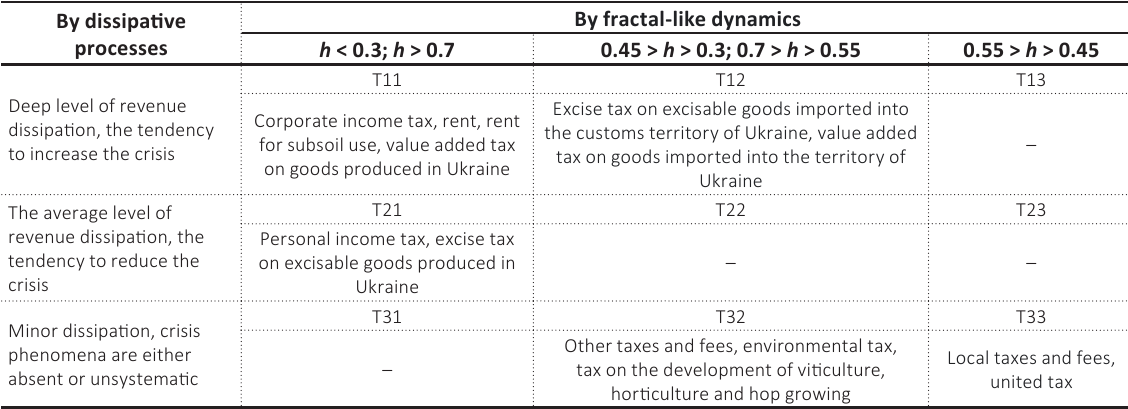
Table 3. Typology of taxes according to the peculiarities of the dynamics of tax revenues By dissipative